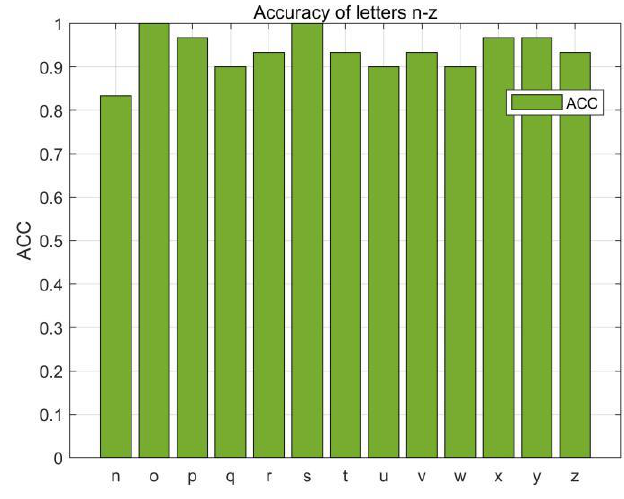
Figure 15. Accuracy of the letters “ n – z ” .